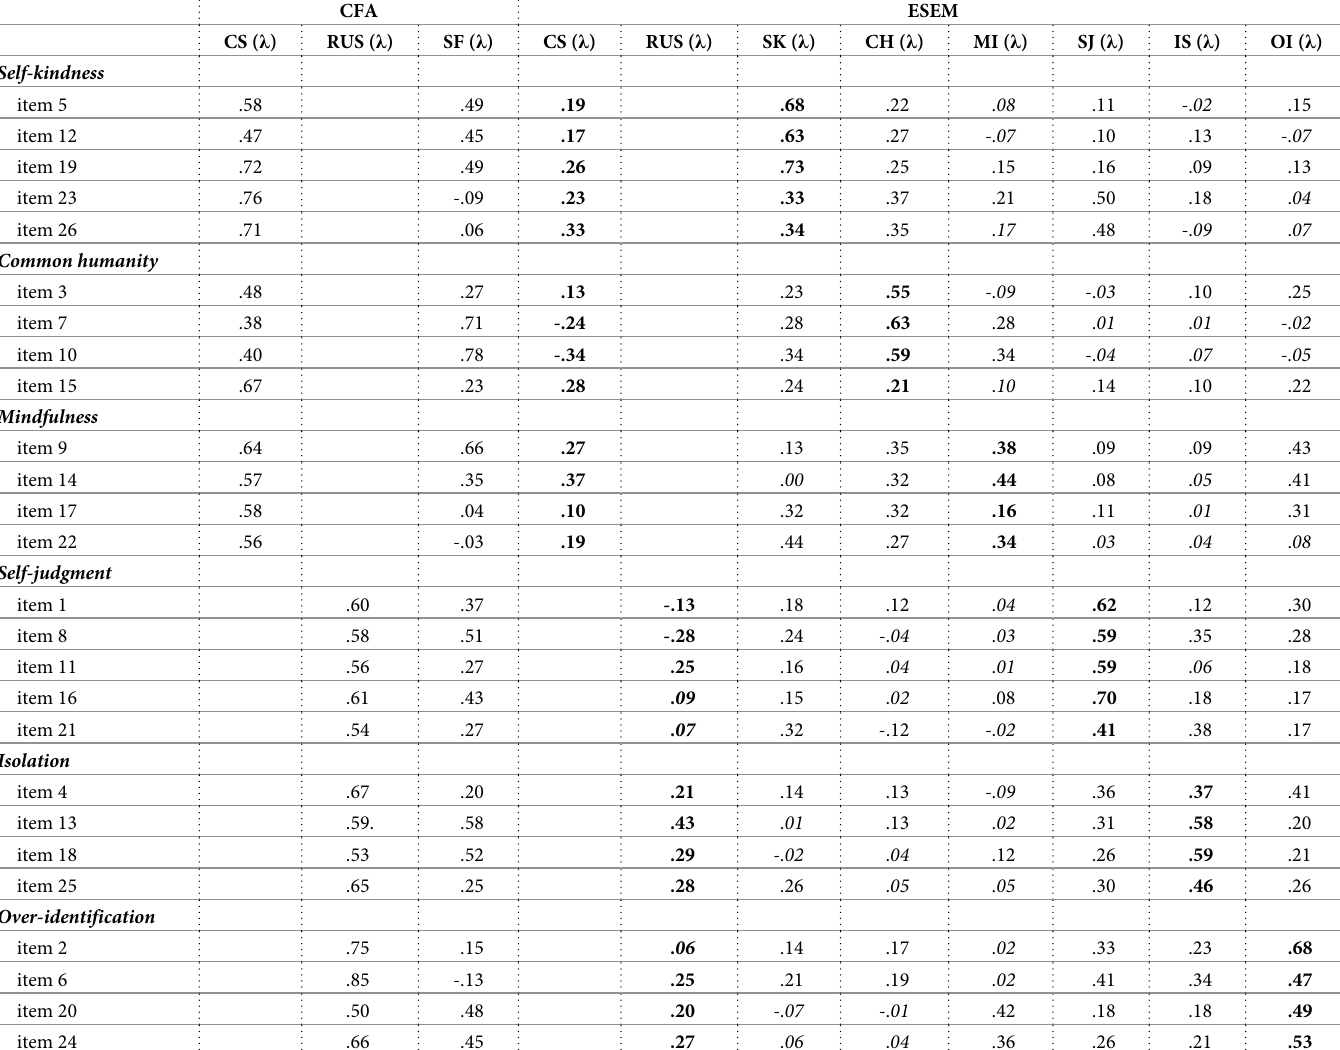
Table 4. Standardised factor loadings for the two-bifactor model: CFA and ESEM